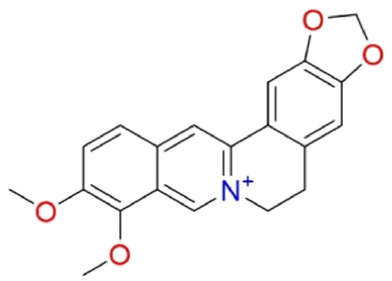
Figure 10. 2D structure of berberine.